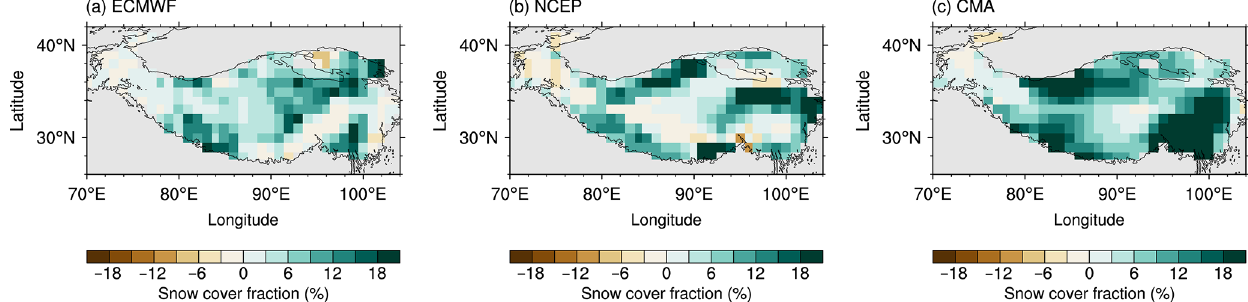
Figure 4. Differences in the multiyear wintertime mean Tibetan Plateau snow cover fraction (unit: %) between forecasts with a lead of 4 weeks and forecasts with a lead of 1 week in (a) ECMWF, (b) NCEP and (c) CMA. The map of the Tibetan Plateau was created by using Global Relief Model data of ETOPO1 (topographic data are free to the public, https://doi.org/10.7289/V5C8276M, National Geophysical Data Center, 2020).